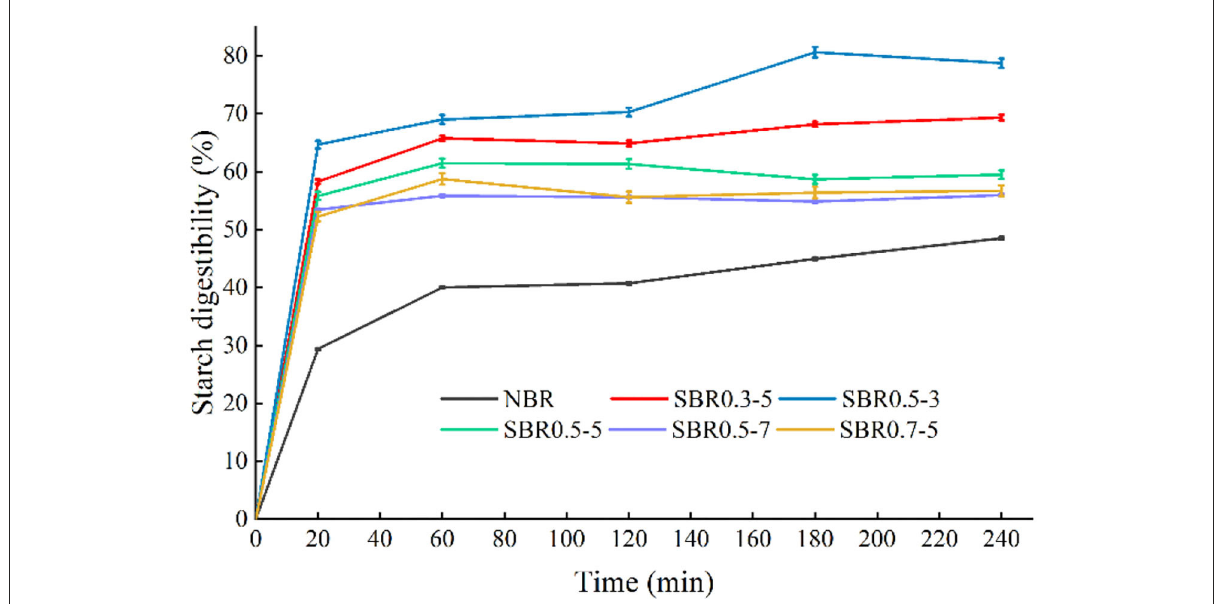
FIGURE3 Effect of steam explosion on in vitro starch digestibility of brown rice powder. NBR, native brown rice powder; SBR, steam exploded brown rice powder; SBR0.3-5, SBR at 0.3 MPa for 5min; SBR0.5-3, SBR at 0.5 MPa for 3min; SBR0.5-5, SBR at 0.5 MPa for 5min; SBR0.5-7, SBR at 0.5 MPa for 7min; SBR0.7-5, SBR at 0.7 MPa for 5min.